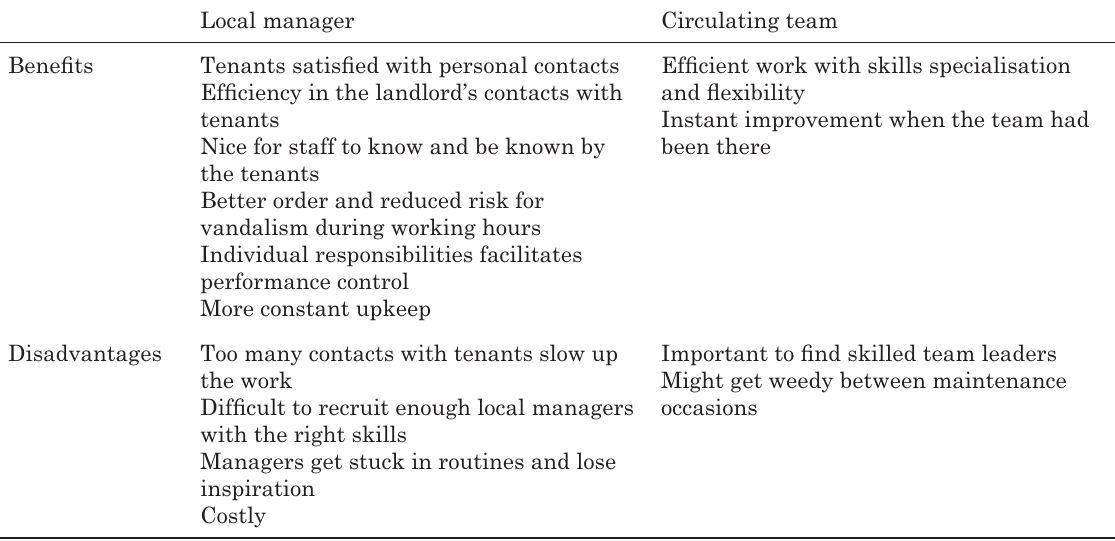
Table 3. Summary of arguments for and against local manager and circulating teams Local